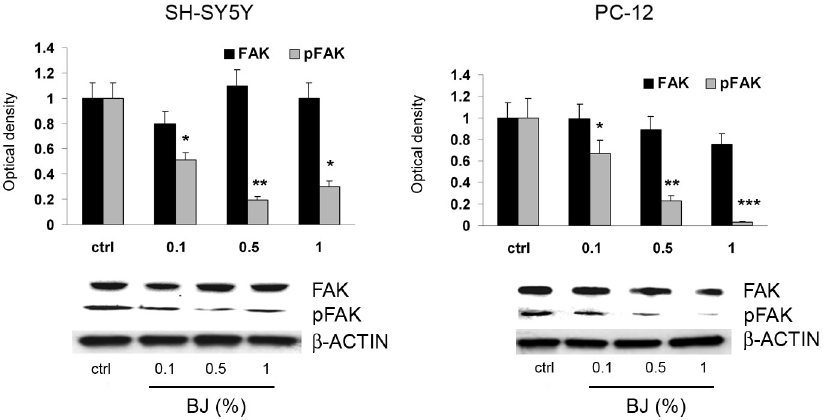
Fig 8. FAK and pFAK expression in SH-SY5Y and PC12 cells treated with BJ. Western blotting analysis of FAK and pFAK expression in SH-SY5Y and PC12 cells treated for 24 hrs with increasing concentration of BJ (0.1%, 0.5% and 1%). Relative densitometric analyses of pFAK and FAK immunoreactive bands are presented in the histograms. Data (mean ± SEM of three experiments) were normalized to the values yielded for β -actin. � P < 0.05, �� P < 0.01 and ��� P < 0.001 vs untreated cells. Note the significant reduction of pFAK by